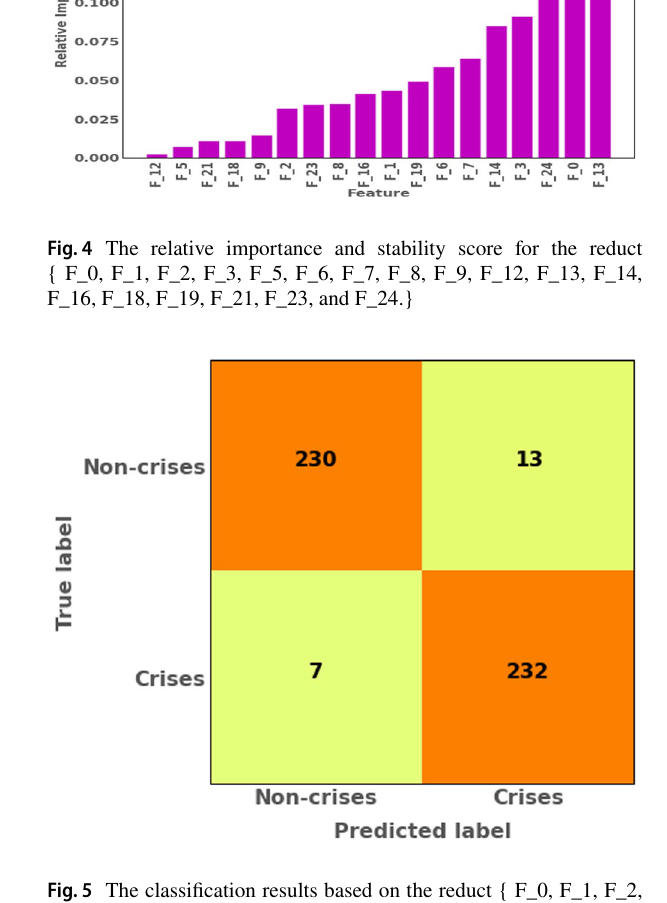
Fig. 5 The classification results based on the reduct { F_0, F_1,